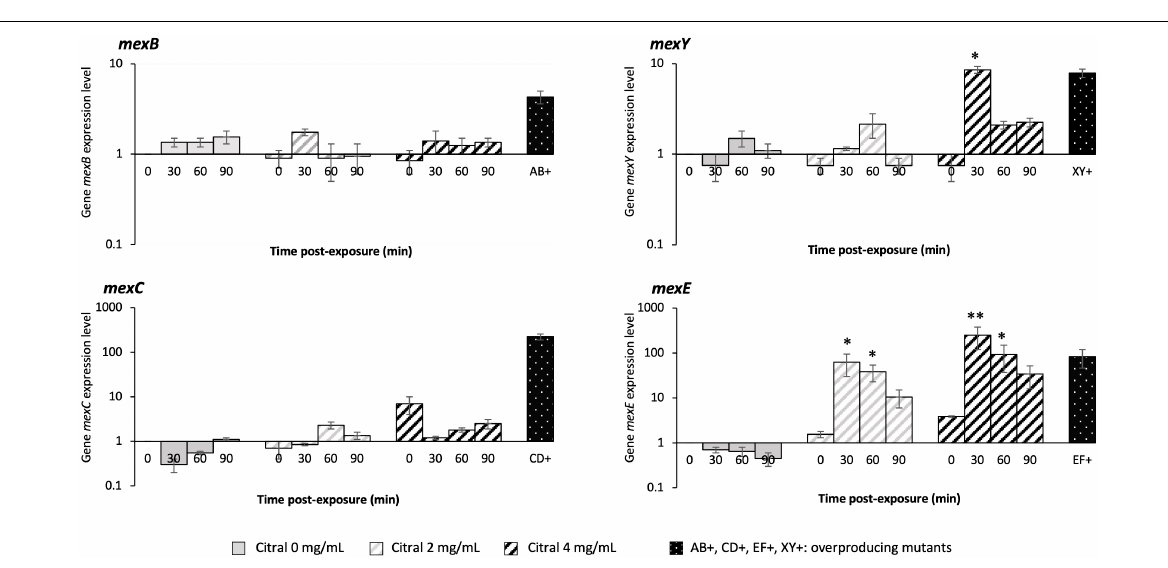
FIGURE 2 | Relative expression levels of P. aeruginosa genes mexB, mexC, mexE, and mexY . Gene transcripts were measured over time by RT-qPCR in strain PA14 exposed to 0, 2, and 4 mg/mL citral. The genes were considered as activated (single asterisk) when their expression was ≥ 3-fold ( mexB ), ≥ 5-fold ( mexY ), and ≥ 20-fold ( mexE and mexC ) that of unexposed PA14 at t 0 . A double asterisk indicates when mRNA amounts were higher than those of efflux overproducing mutants PA14 mexAB + ( mexB : 3.6-fold that of PA14), PA14 mexCD + ( mexC : 257-fold), PA14 mexEF + ( mexF : 47-fold), and PA14 mexXY + ( mexY: 8.7-fold), derived from parental strain PA14. Values are means of two independent experiments each including two technical